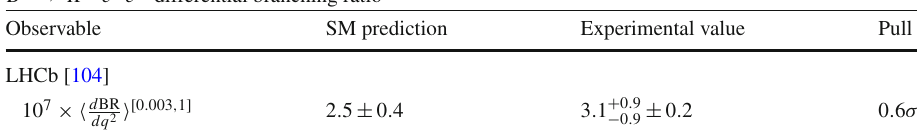
branching ratio of B 0 → K ∗ 0 e + e − included in the